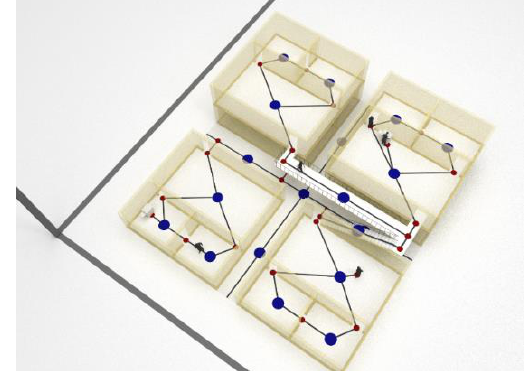
Figure 9 Representation of indoor space as a network. The large blue circles represent locations indoors, they reference general placement. The smaller red circles represent positions or places, and reference specific placement. All placements are assigned